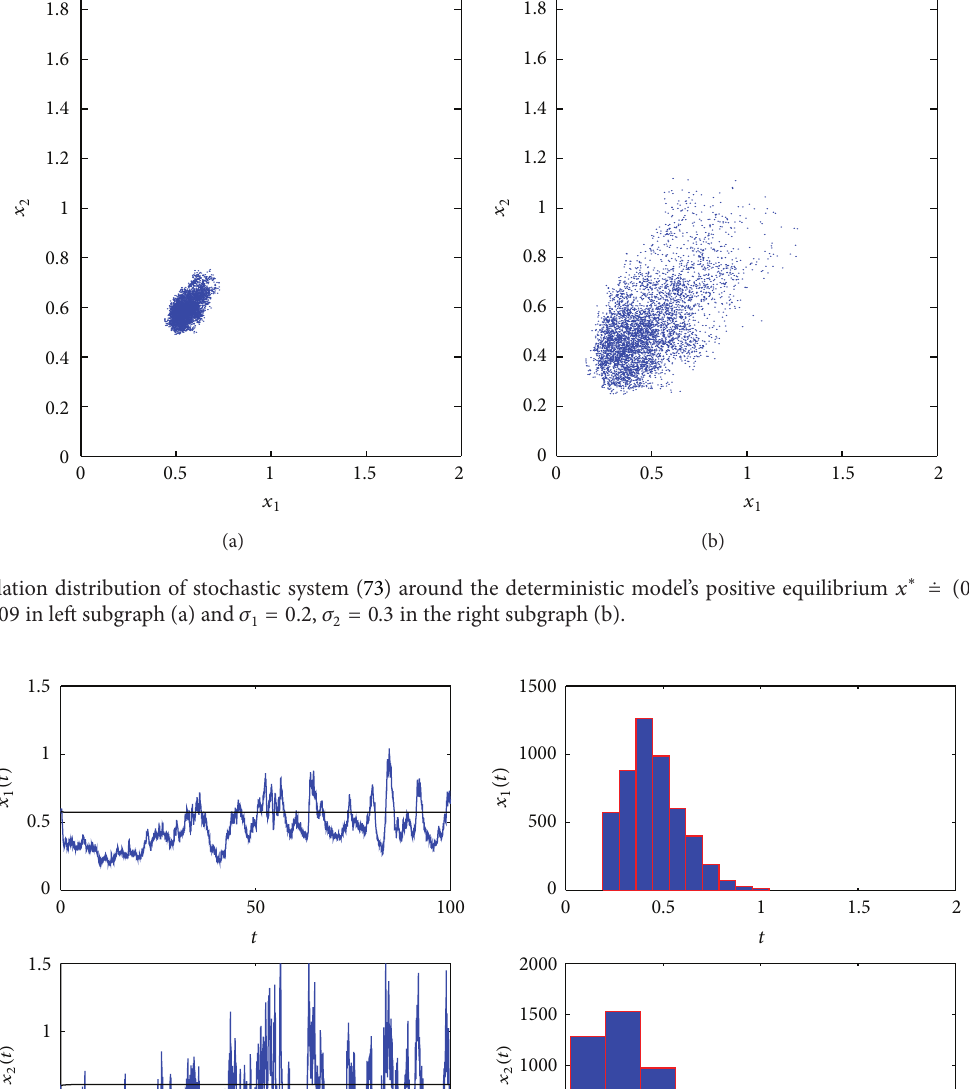
Figure 4: The pictures on the left are the solutions of stochastic system (73) and the corresponding undisturbed system, and the blue lines and the black lines represent them, respectively. The right subgraphs are the histogram of stochastic system (73). 𝜎 1 = 0.2 , 𝜎 2 = 0.8 . 𝑑 12 = 0.6 , = 0.5 𝑑 21